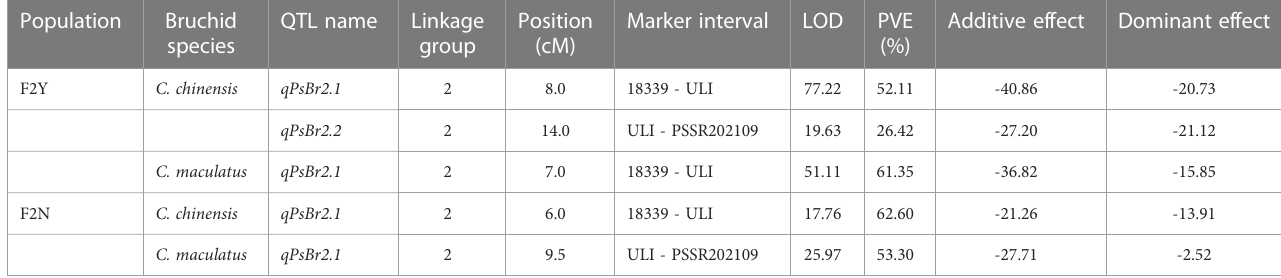
TABLE 1 Summary of the QTLs associated with bruchid resistance across different locations identi fi ed by inclusive composite interval mapping in the pea F 2 populations of the cross PWY19 ×